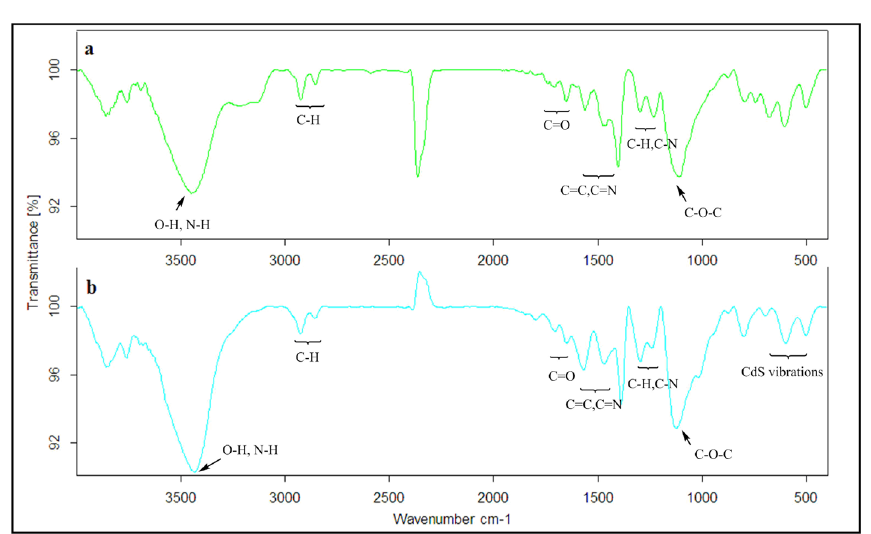
Figure 2. The IR spectra of ( a ) HPEc-g-PANi copolymer and ( b ) CdS@HPEc-g-PANi